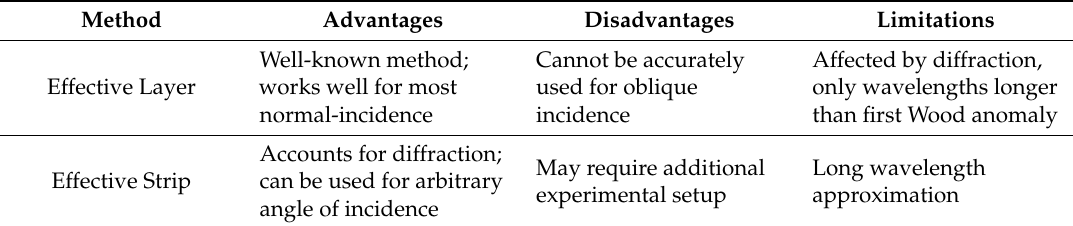
Table 1. Comparison between effective layer and strip methods for parameter